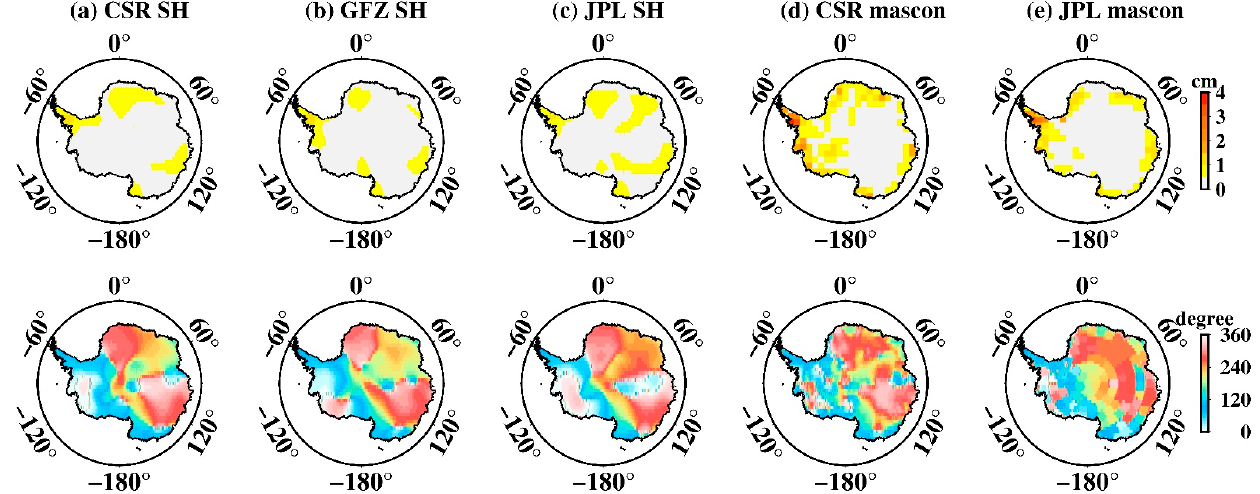
Figure 7. P 1 tide aliasing over Antarctica. ( a – e ) Spatial amplitude and the corresponding phase maps estimated from CSR SH data, GFZ SH data, JPL SH data, CSR mascon data, and JPL mascon data, respectively.